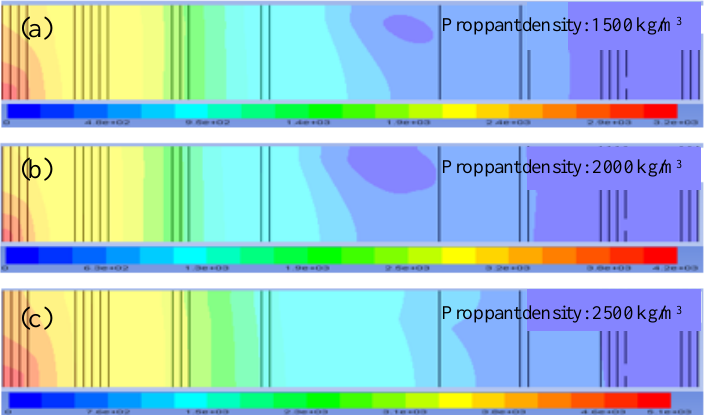
Figure 6. Proppant placement under different proppant densities: (a) 1500, (b) 2000, and (c) 2500 kg/m 3 .